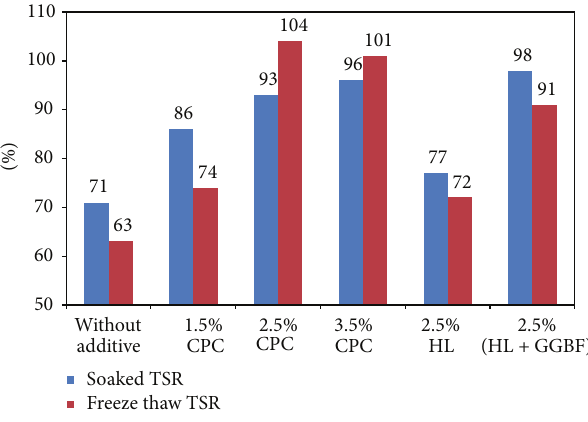
Figure 2: Soaked TSR and freeze thaw TSR